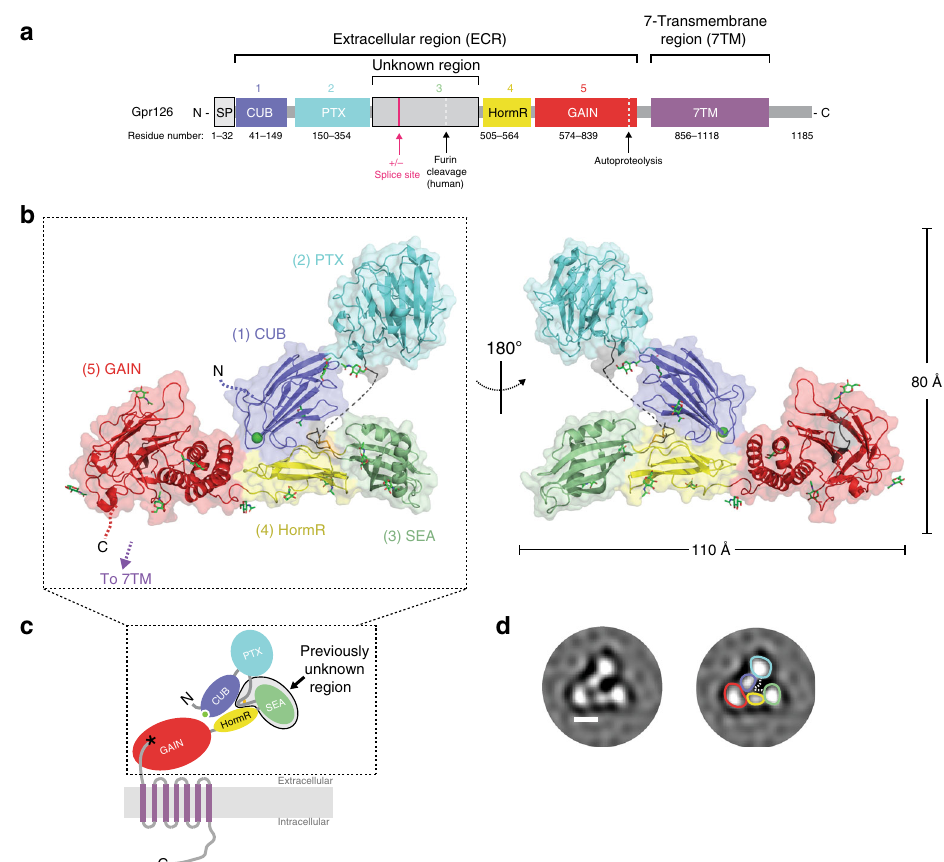
Fig. 1 Crystal structure of the full extracellular region of Gpr126. a Domain organization of Gpr126, indicating the ECR and 7TM regions. The unknown region includes a splice site. Cleavage sites (furin cleavage, autoproteolysis) are indicated by dashed lines. Domains are colored dark blue (CUB), cyan (PTX), gray (unknown region), yellow (HormR), red (GAIN), and purple (7TM). Domain boundaries are indicated below. SP indicates signal peptide. b Structure of the full ECR of ( − ss) Gpr126. Domains are colored as in a except for the newly identi fi ed SEA domain (green). Domains are numbered (1 – 5) from N to C-terminus. Calcium ion in CUB domain is indicated as a green sphere. Dashed lines represent disordered residues. N-linked glycans are shown as green sticks. c Schematic of full-length Gpr126. The previously unknown region (SEA domain and linker region) is labeled. Autoproteolysis in GAIN domain is indicated by an asterisk and the last beta-strand of the GAIN domain is colored gray. d Representative negative-stain EM 2D class average of Gpr126 ( − ss) ECR. Scale bar (white) represents 50 Å. Domains are assigned and colored according to color scheme noted above. The dashed line represents the linker